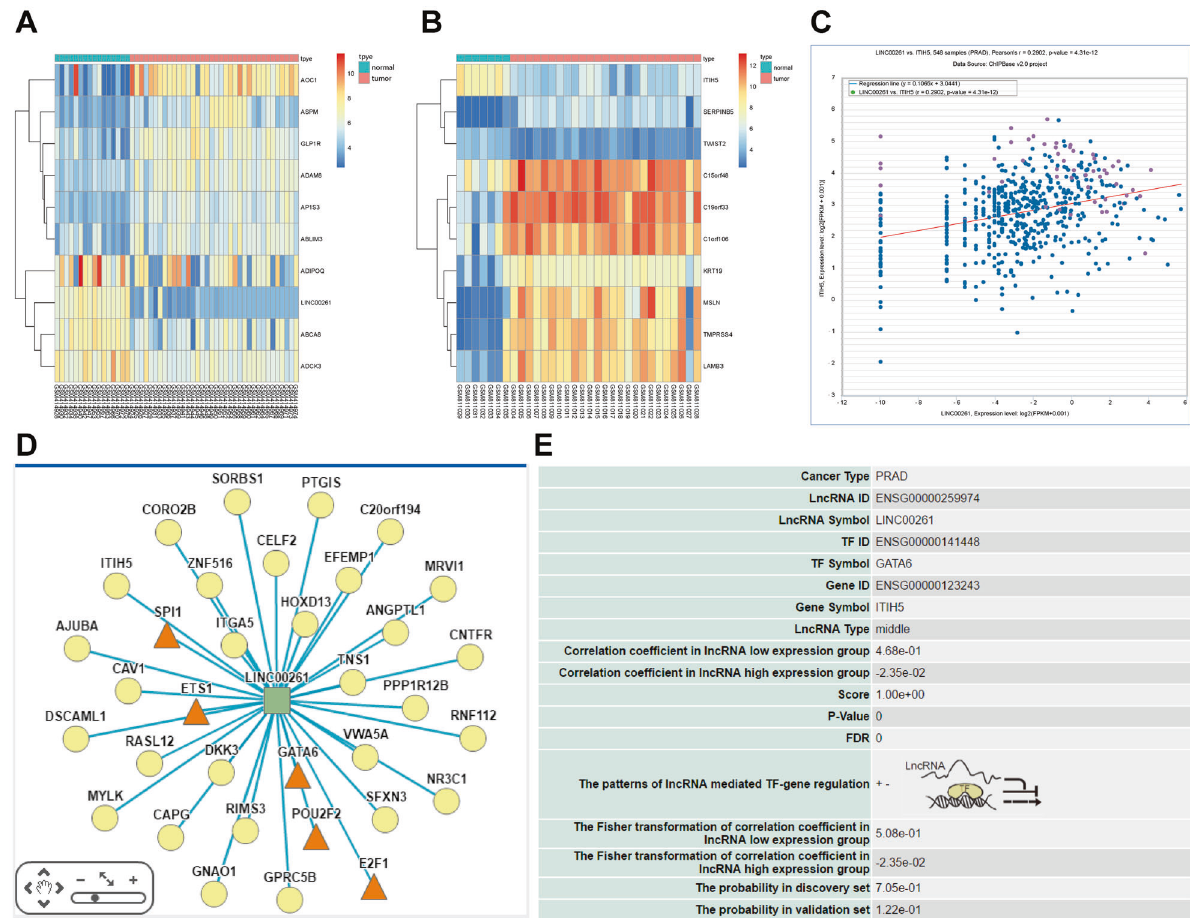
Fig. 1 LINC00261 and ITIH5 are downregulated in PC. A The heatmap of GSE16515 expression dataset. B The heatmap of GSE32676 expression dataset. C Coexpression of LINC00261 and ITIH5 analyzed by ChIPBase website. D Possible regulatory mechanism of LINC00261 predicted by the lncMAP website. E Possible regulatory mechanism of LINC00261 regulating ITIH5 predicted by the lncMAP website. PC pancreatic cancer, ITIH5 inter-alpha-trypsin inhibitor heavy chain H5. According to the ChIPBase website (http://rna.sysu.edu.cn/ chipbase/index.php), LINC00261 was positively correlated with ITIH5 in PC (Fig. 1C). The lncMAP website (http://bio-bigdata. hrbmu.edu.cn/LncMAP/search.jsp) was used to predict the possi- ble regulatory mechanism of LINC00261 (Fig. 1D), with the results showing that LINC00261 may regulate the expression of ITIH5 through the transcription factor GATA6 in PC (Fig. 1E). These results indicate that LINC00261 is downregulated in PC tissues, while ITIH5 expression followed a similar pattern.